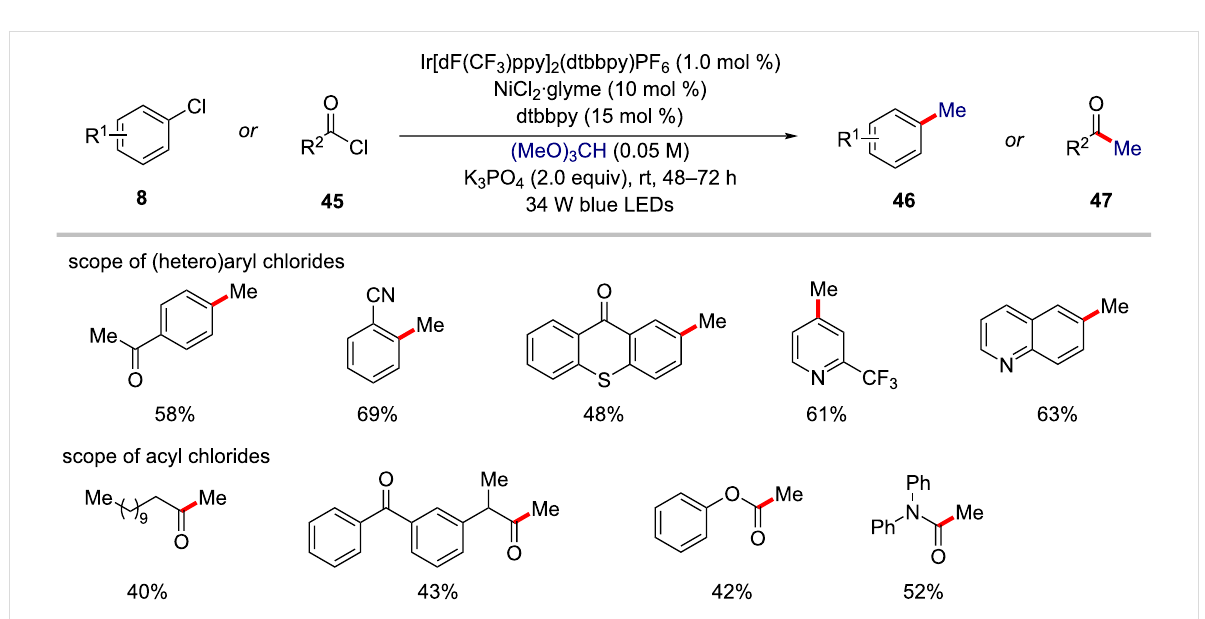
Scheme 28: Nickel/photoredox-catalyzed methylation of (hetero)aryl chlorides and acid chlorides using trimethyl